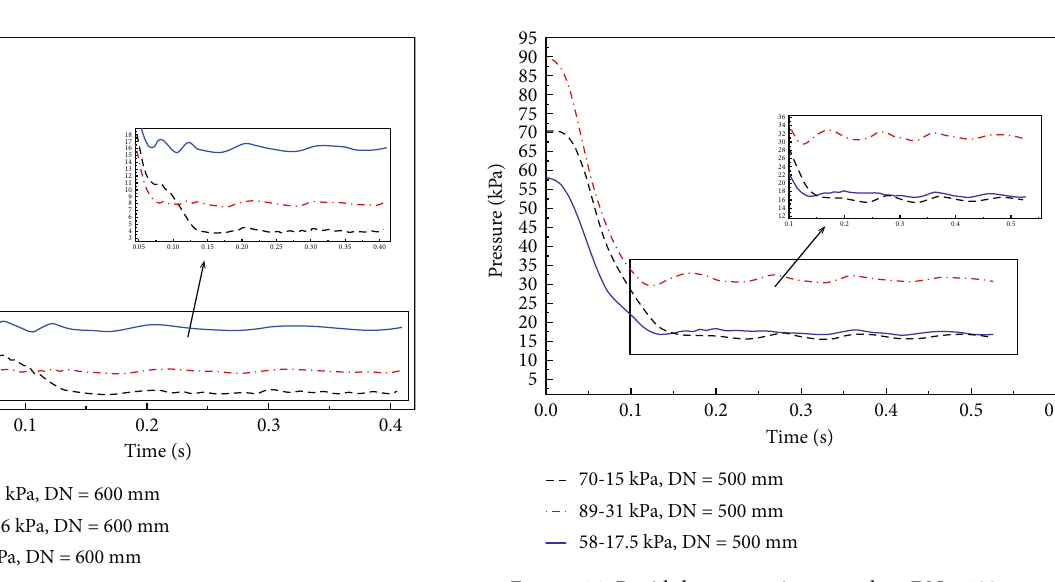
Figure 12: Rapid decompression test when DN = 600 mm